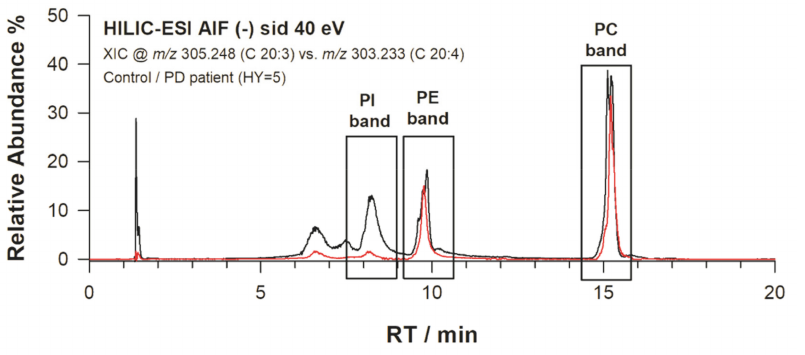
Figure 6. Abundance of FA C20:3 normalized with that of FA C20:4 compared between a control and a Parkinson’s disease (PD) patient having Hoehn and Yahr [39] stage 5. Apparently, the FA C20:3 of PI 38:3 is down regulated in the PD